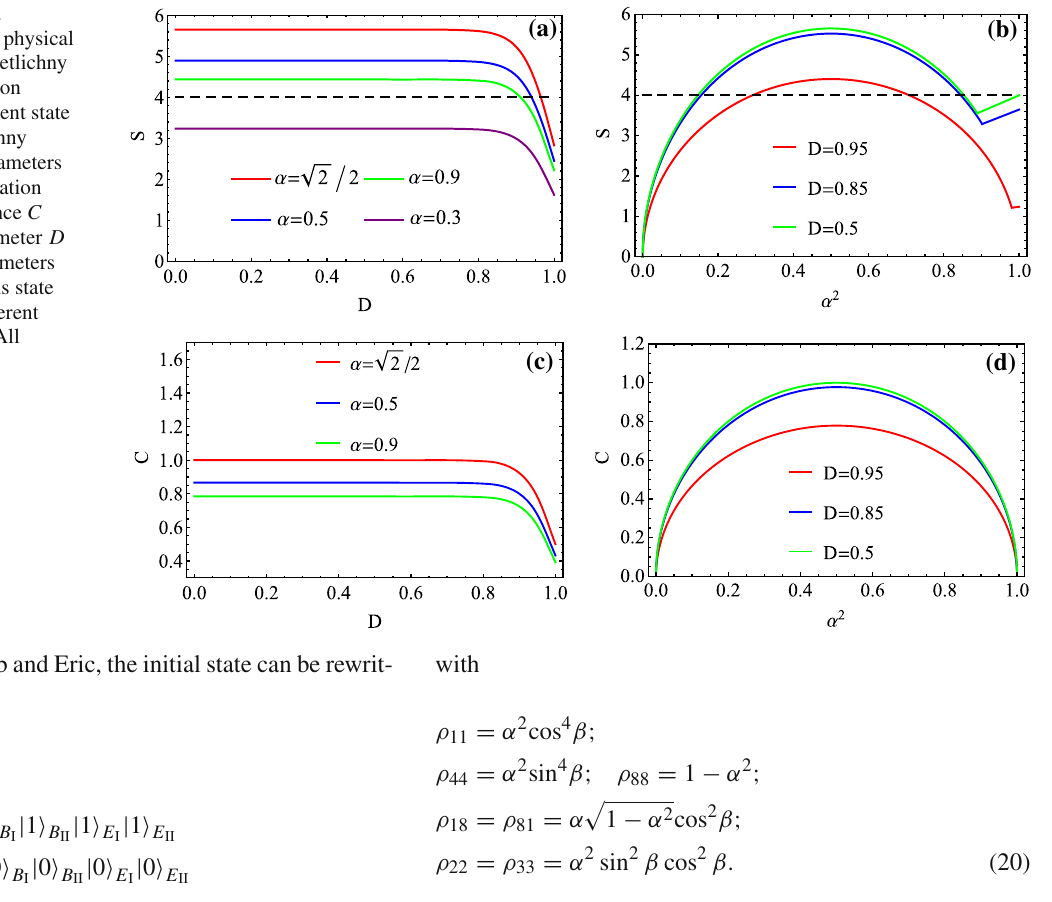
Fig. 1 Nonlocality and coherence for ρ AB in physical I E I accessible regions. a Svetlichny value S versus the dilation parameter D with different state parameters α ; b Svetlichny value S versus state parameters α 2 the with different dilation parameter D ; c Coherence C versus the dilation parameter D with different state parameters α ; d Coherence C versus state parameters α 2 with different dilation parameter D . (All plotted with M =